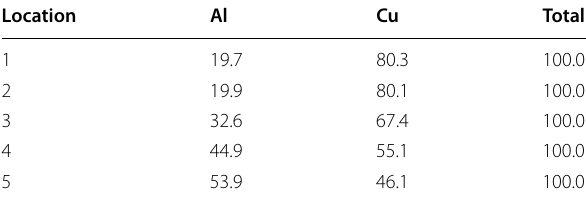
Table 2 EDX quantification results (wt%) indicated in Figure 5 Location